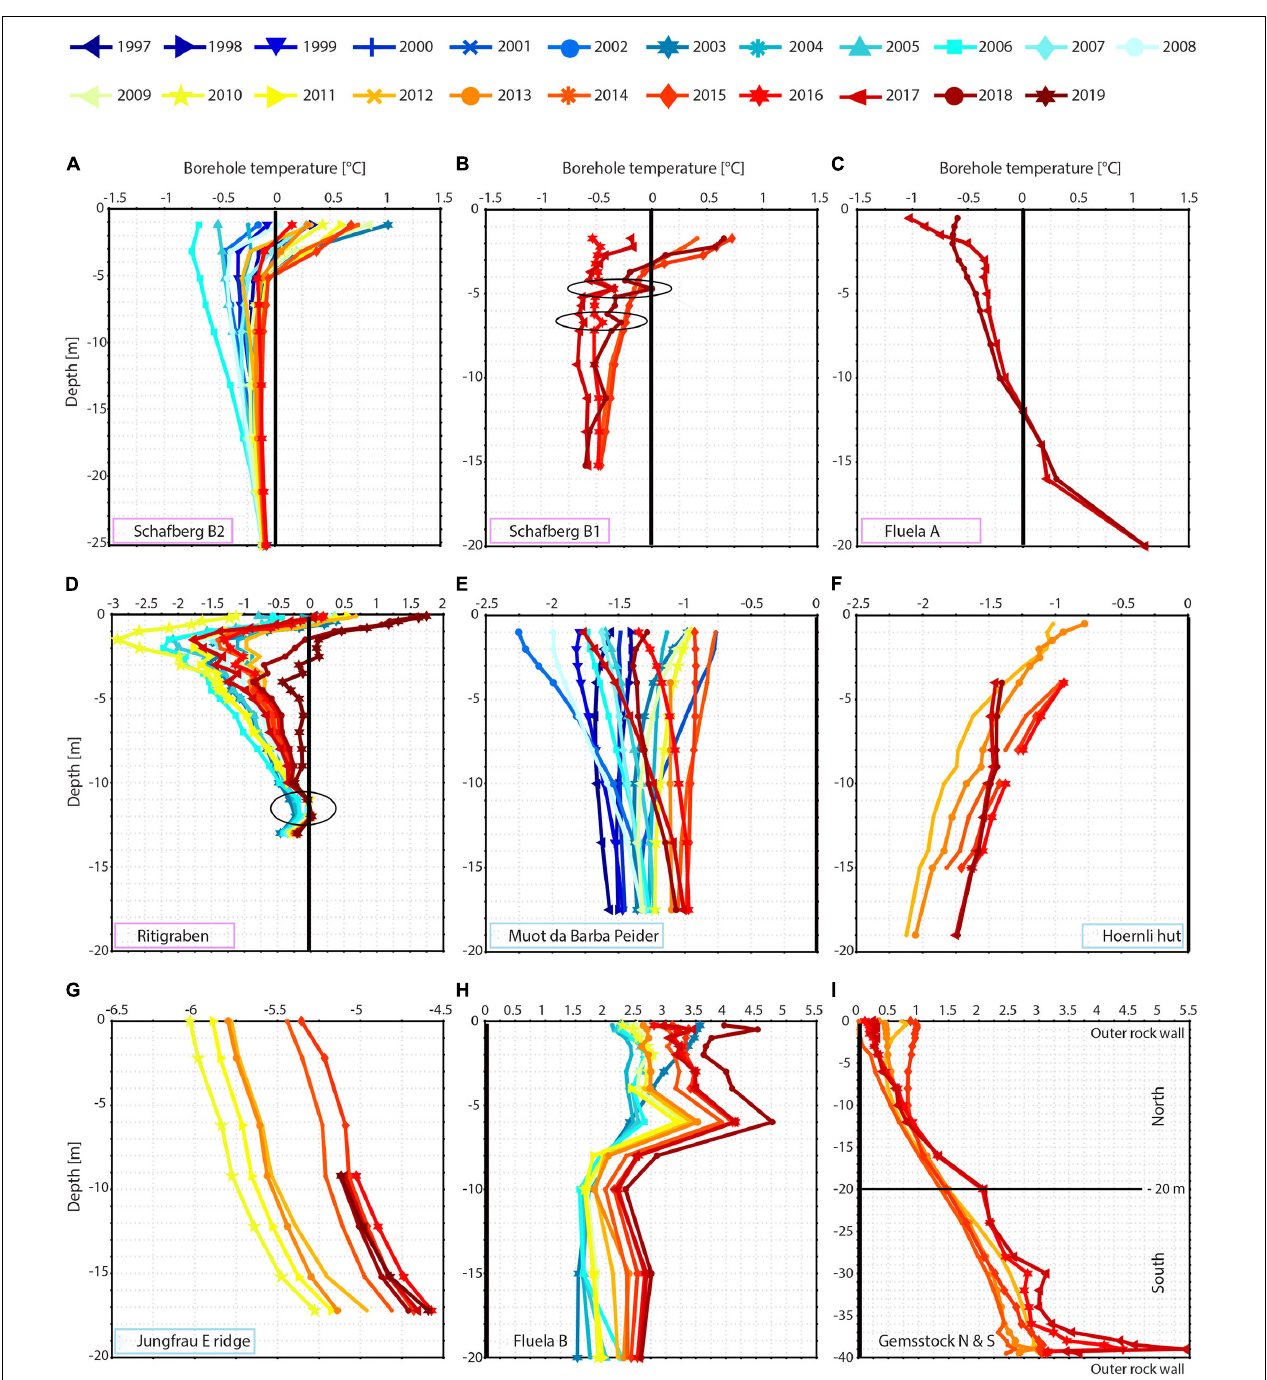
FIGURE 7 | Vertical temperature profiles of mean annual ground temperatures in all permafrost boreholes. Thermistor depths in the boreholes are given (not the distance to the ground surface). The black vertical line denotes the 0 ◦ C isotherm (where applicable). Note the different x - and y -axis scales. Temperatures at depths of seasonal taliks (black circles) are below 0 ◦ C because mean annual ground temperatures are presented. The coloured frames indicate the ice content of the boreholes: (A–D) pink for ice-rich, (E–G) light blue for ice-poor, and (H,I) no frame for permafrost-free locations.